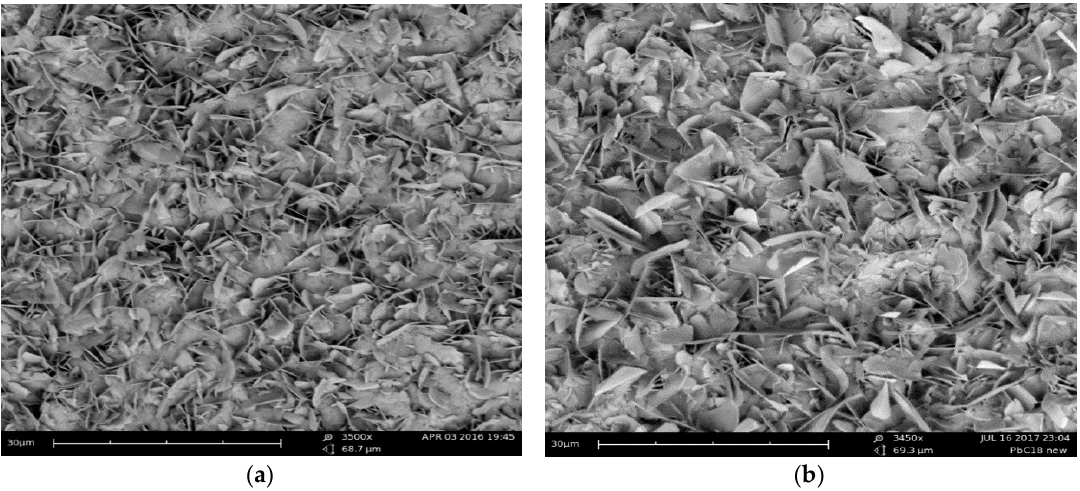
Figure 2. Backscattered electron images of the coating obtained from NaC 18 without stirring ( a ) and NaC 18 with stirring ( b ).